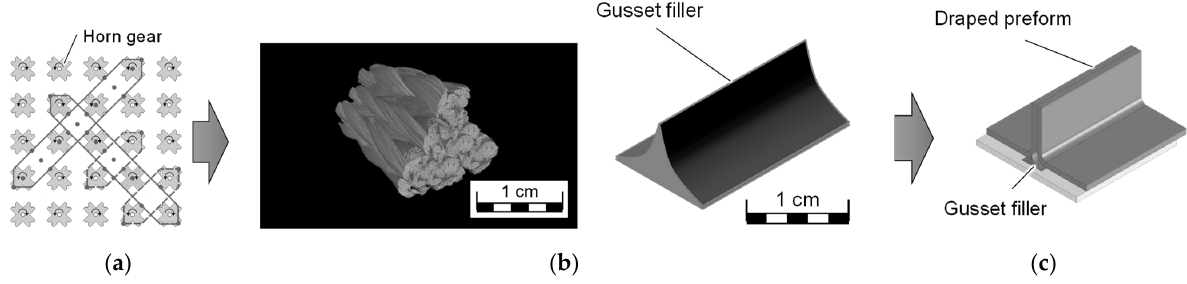
Figure 15. Braiding pattern of a gusset filler ( a ); CT image and sketch of a gusset filler ( b ); and gusset filler in draped preform ( c ).